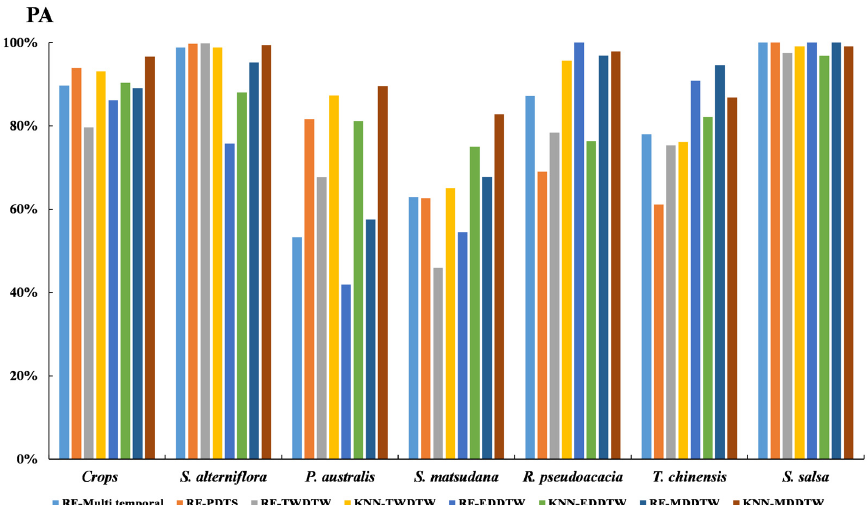
Figure 10. Producer accuracy of different classification methods.